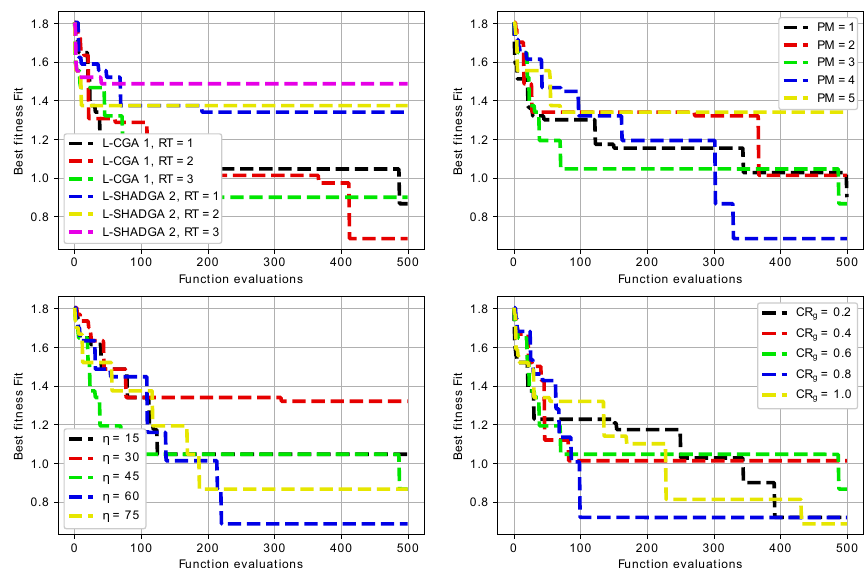
Figure 9. Convergence graphs of algorithms with different parameters for 6-mode resonator.